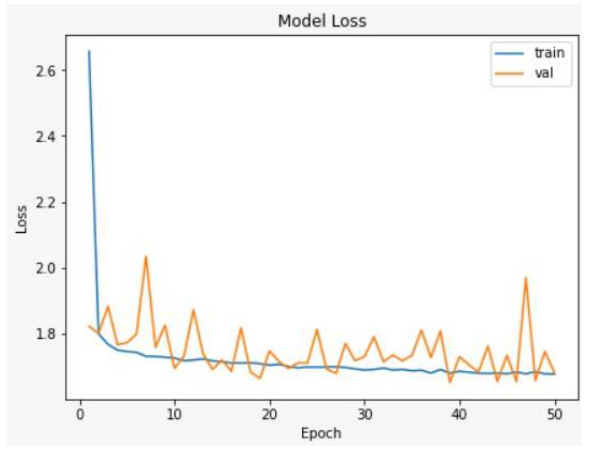
Fig. 5. Accuracy and loss curve after first training ResNet.